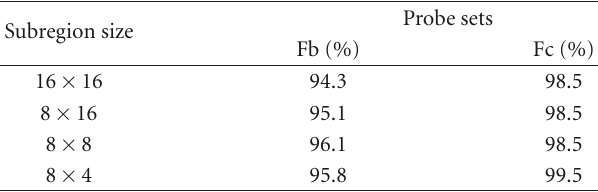
Table 2: Recognition rates for di ff erent sizes of the subregion (direct Atan